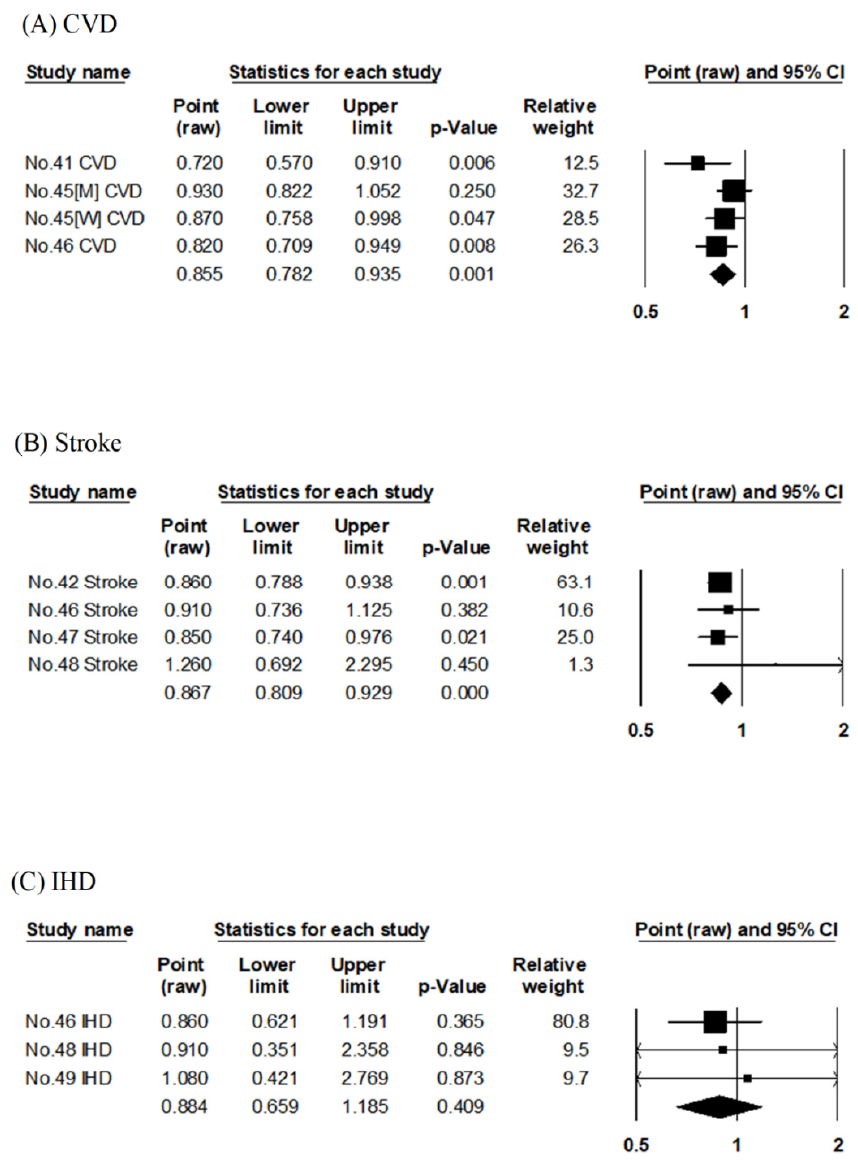
Figure 5. Meta-analysis of fish consumption and mortality risk. ( A – C ) show the association between fish consumption and CVD, stroke, and IHD mortality risk, respectively. The area of each square is proportional to the study weight. Horizontal lines represent 95% confidence intervals. Diamonds represent pooled estimates from inverse-variance-weighted random-effects model. The number given in the study name indicates that of the cited reference [41,42,45–49]. CVD; cardiovascular disease, IHD; ischemic heart disease.